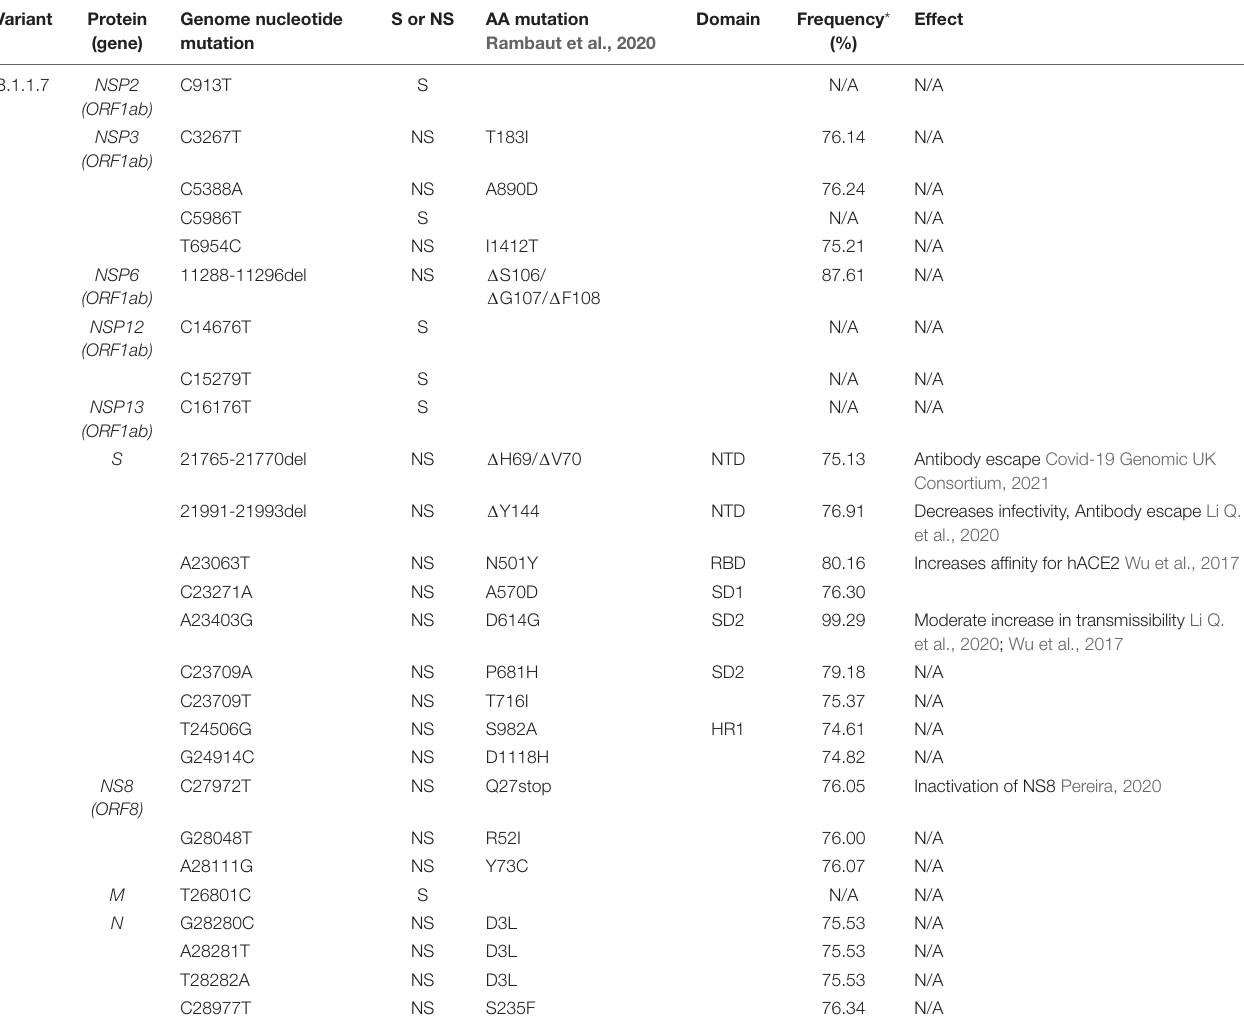
TABLE 2 | Synonymous, non-synonymous, and deletion mutations in the B.1.1.7 (United Kingdom)